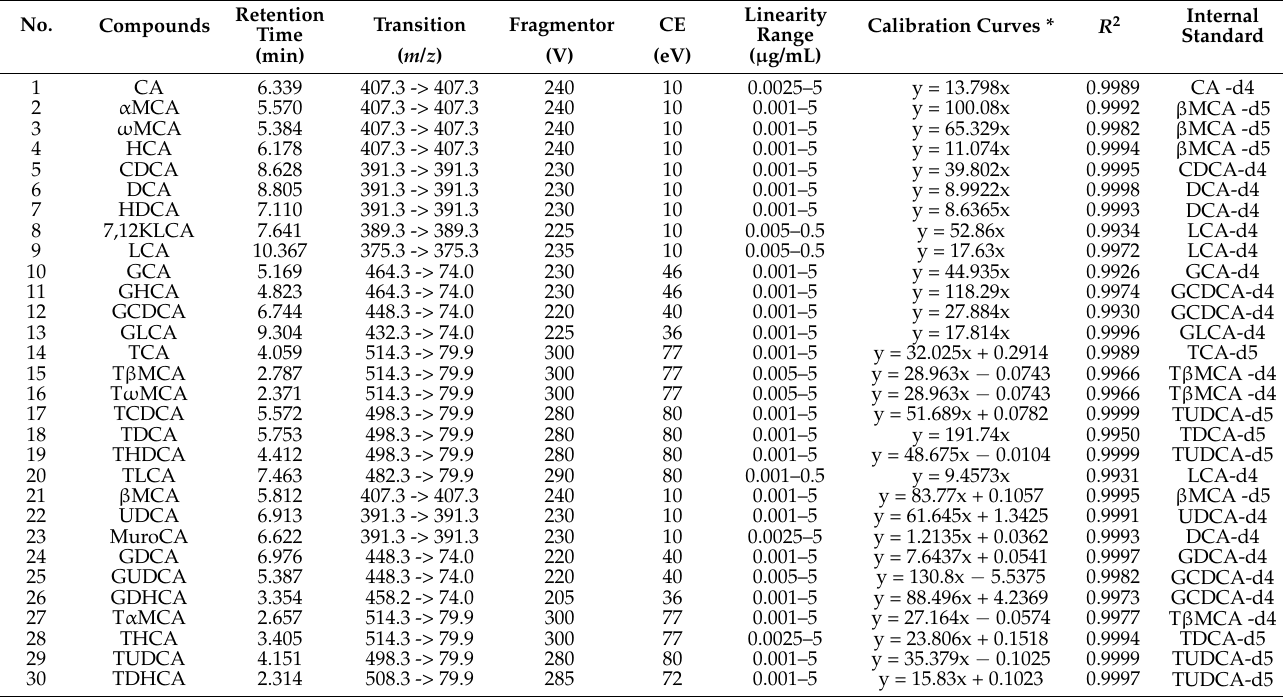
Table 1. Parameters for quantification on BAs by